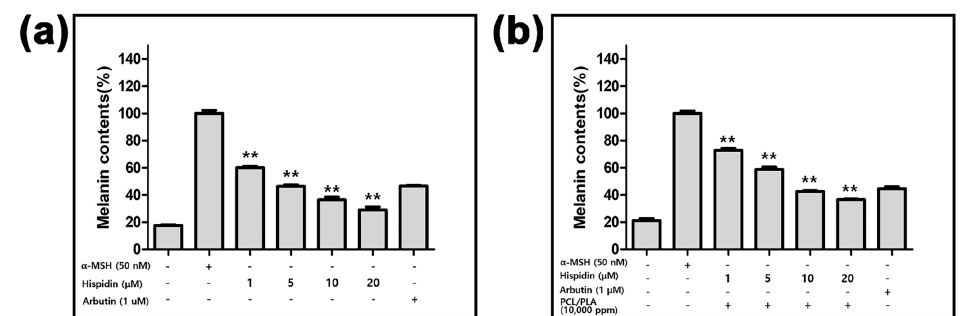
Figure 4. Effects of hispidin and mixtures of substance on melanogenesis using B16F10 melanoma cells. ( a ) B16F10 cells were treated with various concentrations (1–20 µM) of hispidin. ( b ) B16F10 cells were pretreated with hispidin (1–20 µM) mixed with PCL/PLA at identical concentrations (10,000 ppm) . ** p < 0.01 versus control.